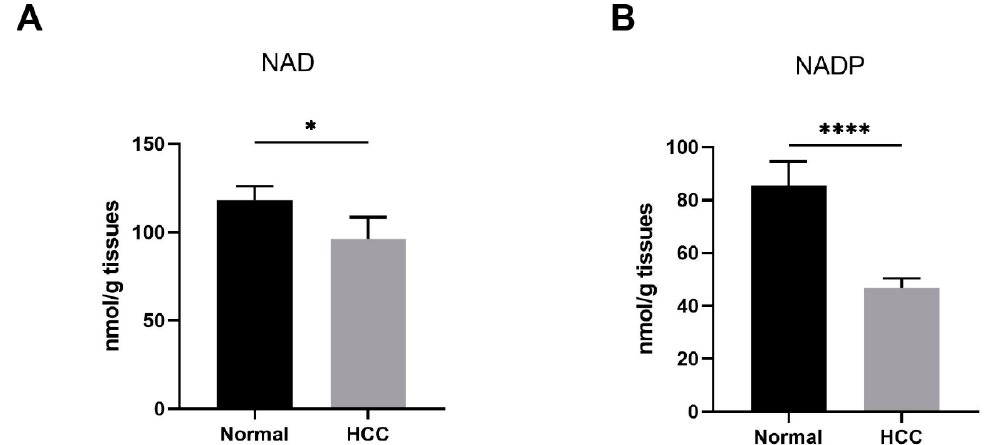
human liver samples. Normal, liver tissues far from HCC nodules, n = 33. HCC, n = 38. * p < 0.05, **** p < 0.0001 compared to the normal tissues. p -values were calculated using Mann – Whitney test. HCC, hepatocellular carcinoma; NAD, nicotinamide adenine dinucleotide; NADP, nicotinamide adenine dinucleotide phosphate.